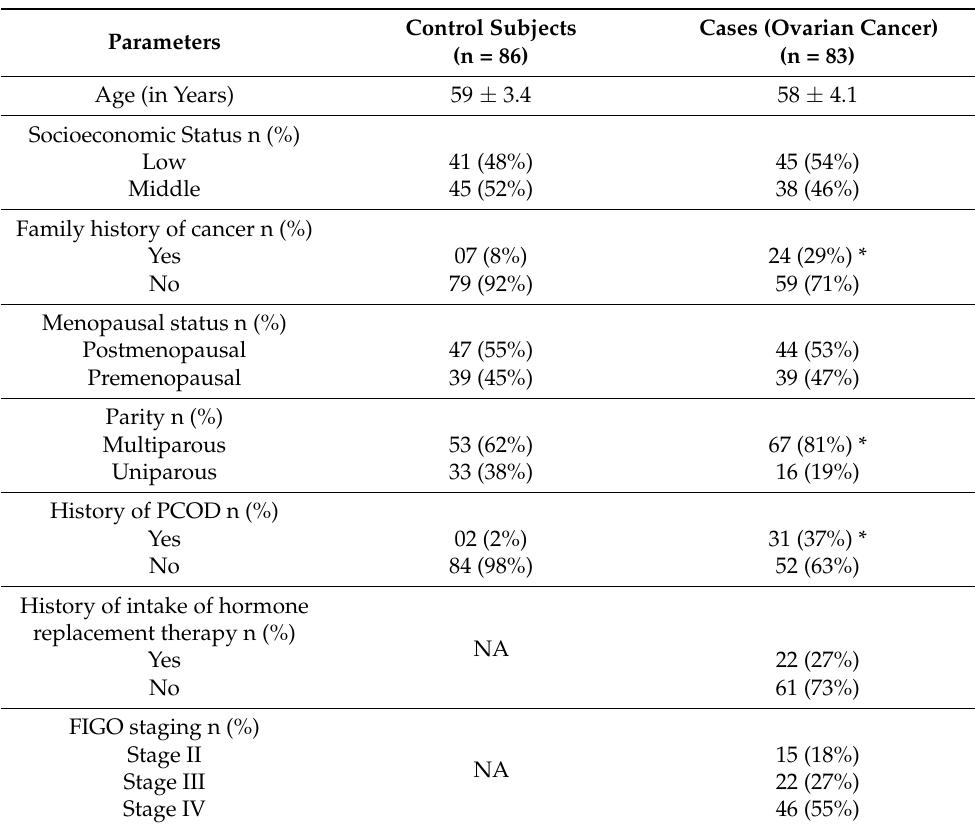
Table 1. Clinico-demographic profile of the study